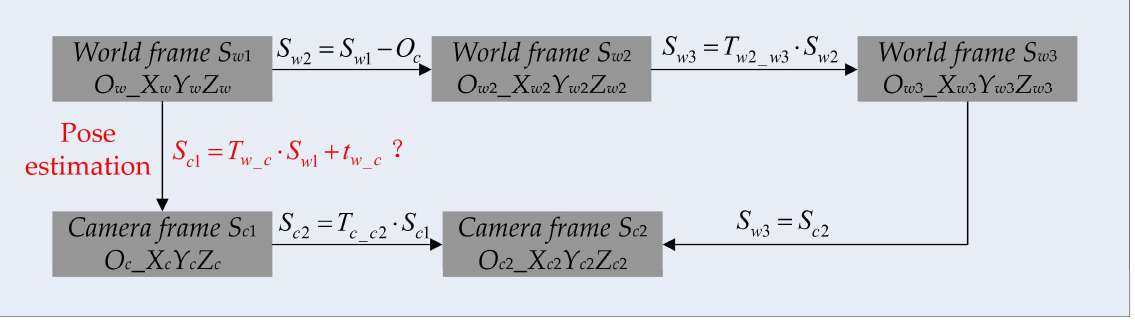
Figure 4. The transformations between each pair of frames. The transformation written in red is what needs to be solved in this paper, and this transformation contains all the pose information.